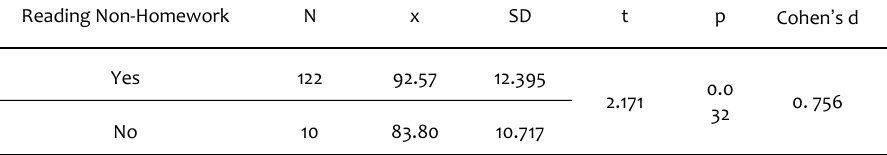
Table 8. Students' reading motivation scores in relation to reading books apart from homework Reading Non-Homework